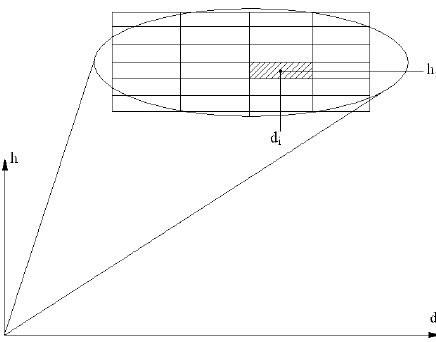
Figure 1: Schematic view of the division of the measuring volume into subvolumes of height hi and length di. Note that for the calculation we constructed overlapping subvolumes not shown in the figure. Fig. 1. Schematic view of the division of the measuring volume into sub-volumes of height h i and length d i . Note that for the calculation we constructed overlapping sub-volumes not shown in the figure.